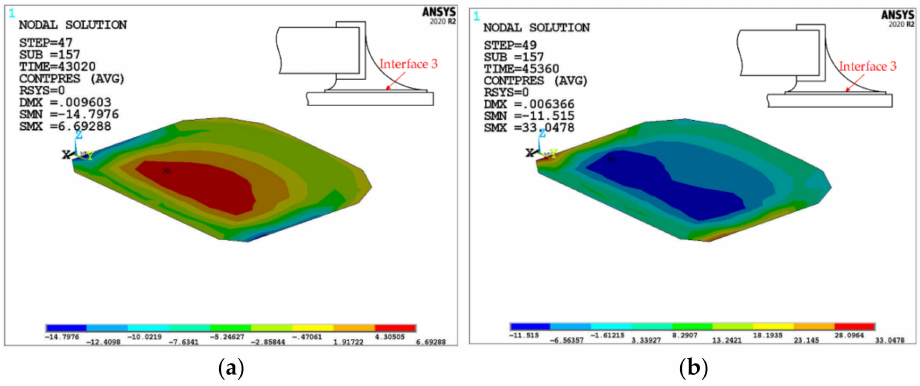
Figure 11. Contact pressure (unit: MPa) distribution at interface 3. ( a ) at 125 ◦ C; ( b ) at − 45 ◦ C.